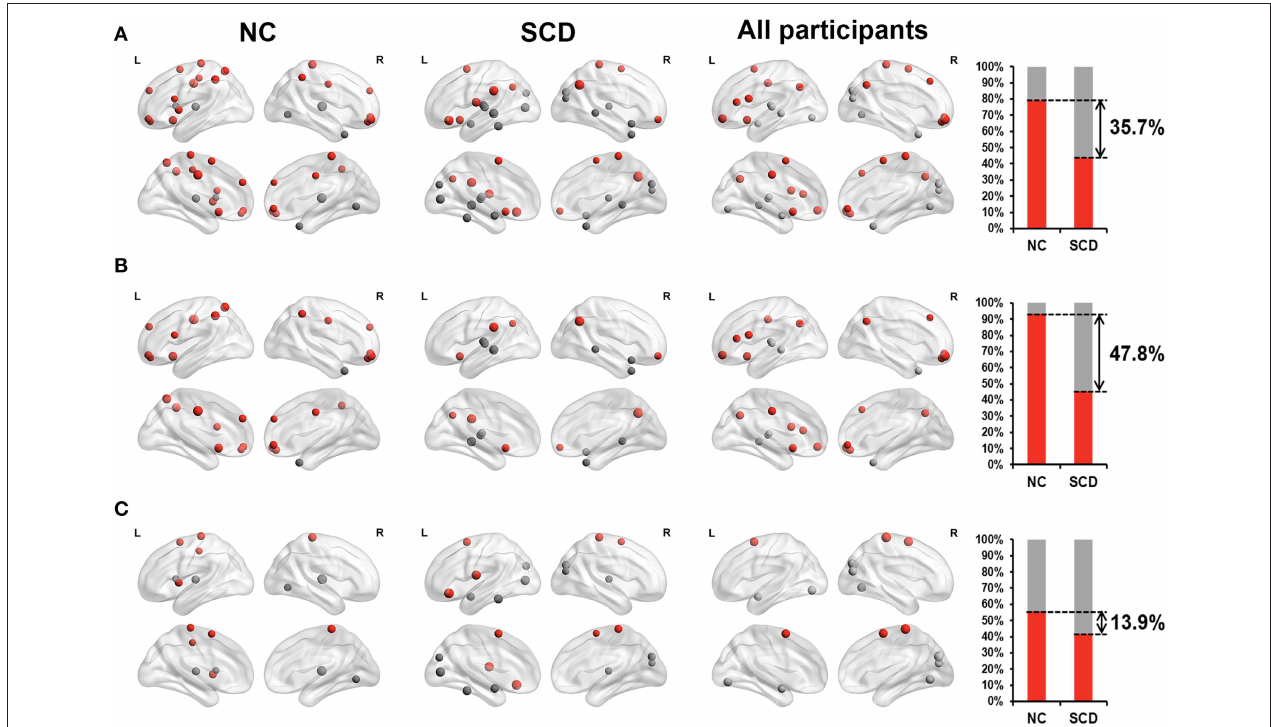
FIGURE 3 | Relationship between hub probability measured by dynamic functional connectivity of brain regions and neuropsychological tests in NC group (the first column), SCD group (the second column) and all participants (the third column). The forth column showed the proportion of significant correlated regions ( p < 0.05) located in anterior (red) cortical and other (gray) cortical regions in the two groups. The nodes covered by red are located in anterior cortical regions. By contrast, nodes covered by gray are located in posterior cortical regions or subcortical regions. The size of each node represents the absolute value of standardized ß. Nodes are located according to their centroid stereotaxic coordinates. (A) All the significant correlated regions ( p < 0.05). (B) The regions in the default mode network. (C) The regions out of the default mode